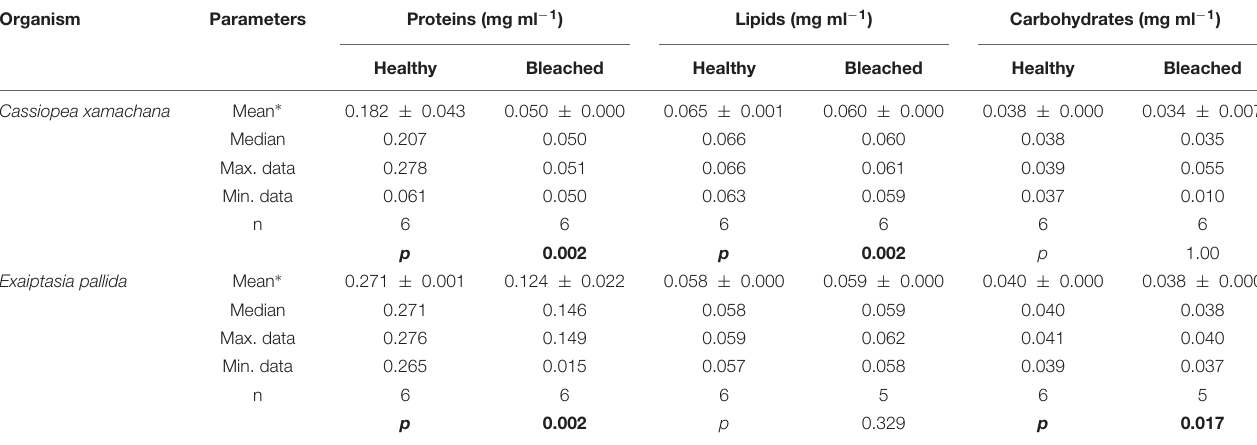
TABLE 5 | Total protein, lipid and carbohydrates in mucus samples collected from healthy and bleached C. xamachana and E. pallida.